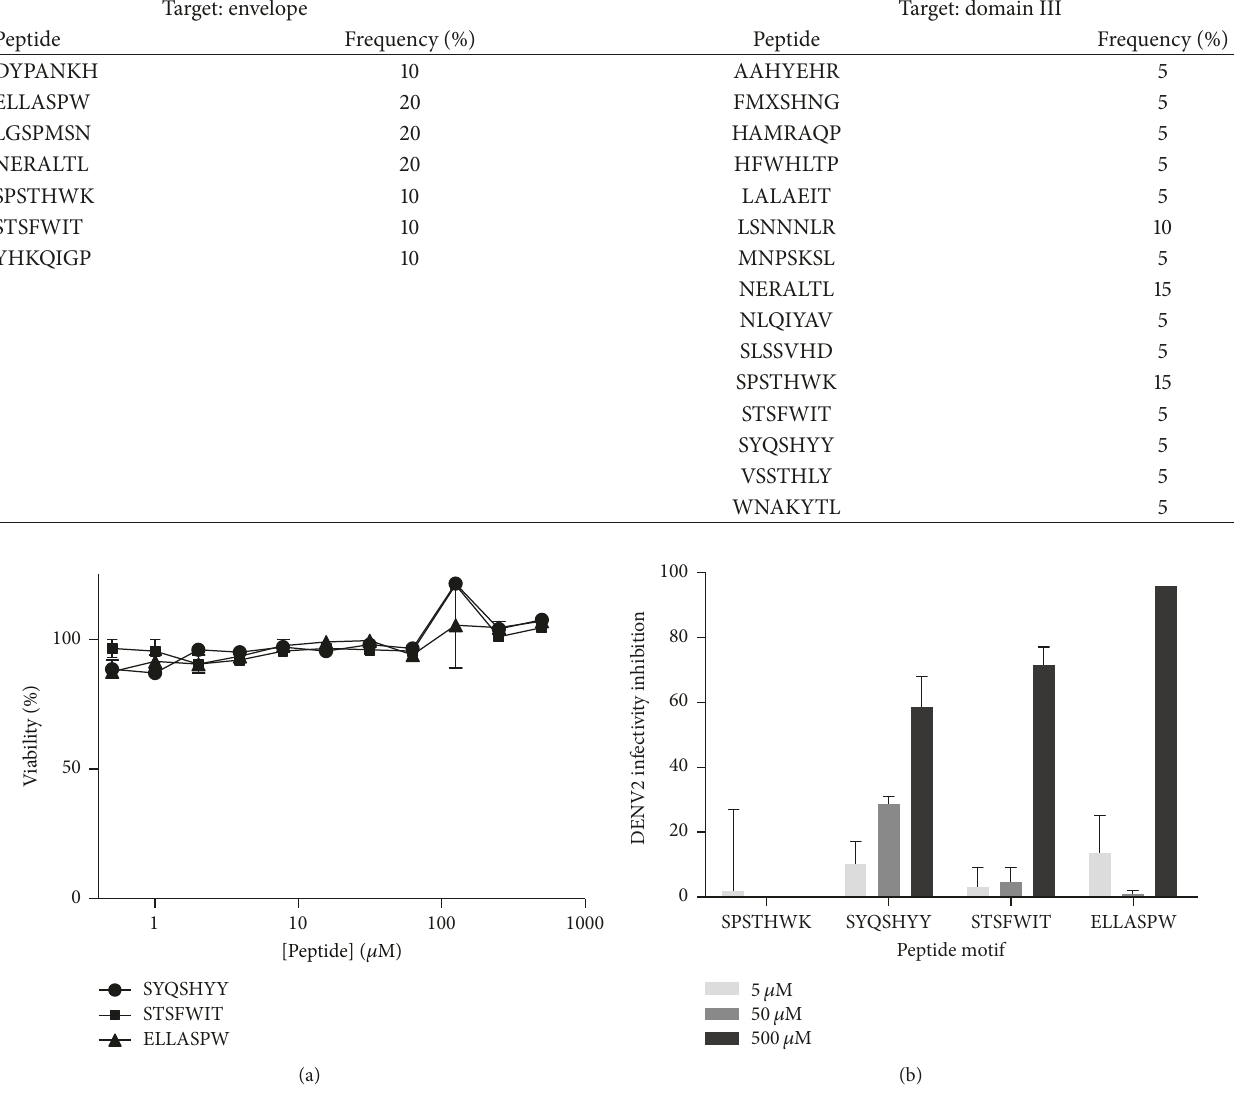
Table 1: Peptide sequences at the randomized region and frequency of appearance of bearing phages.